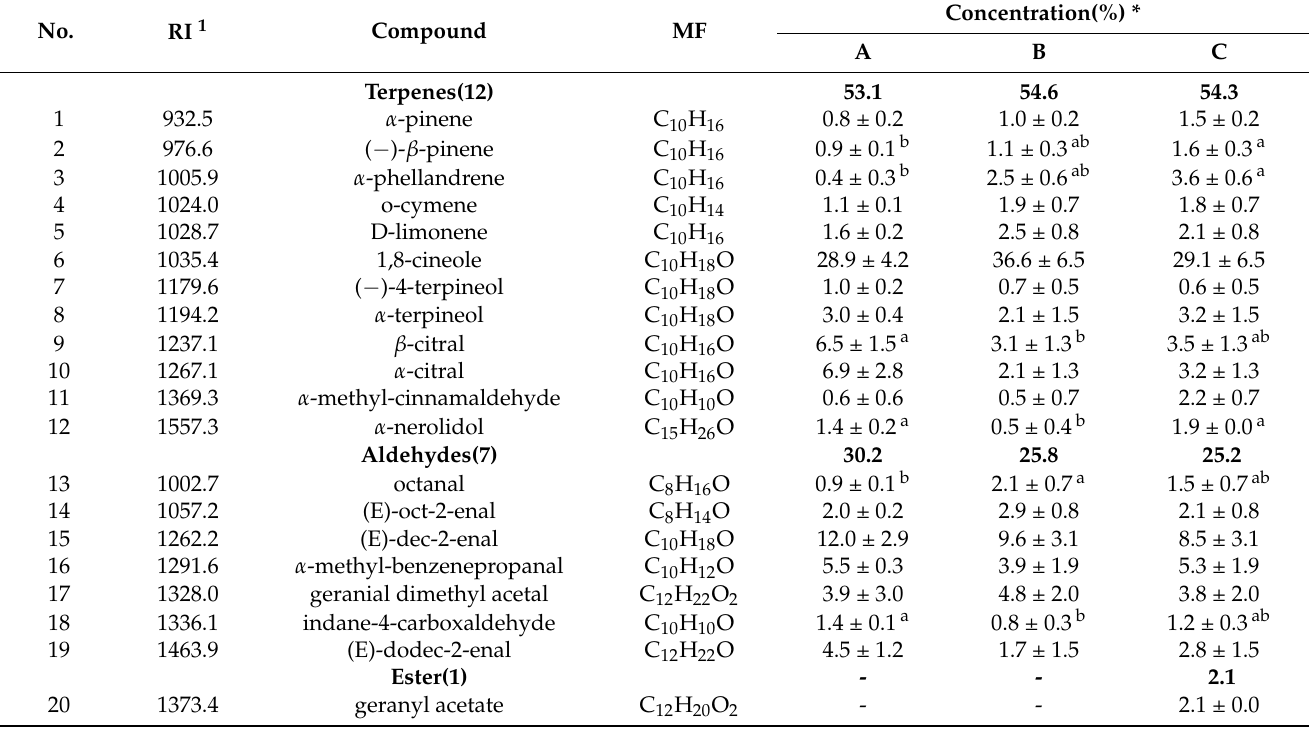
Table 1. Main compounds in AEOs detected in gas chromatography–mass spectrometry